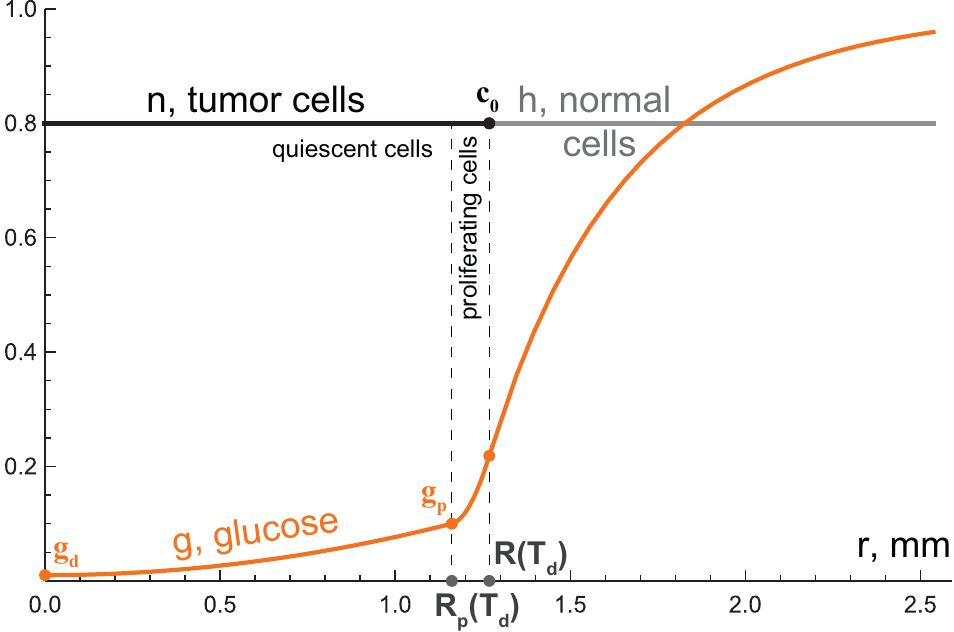
Figure 3. The distributions of the variables of the tumor growth model, governed by the system of Equation (6) at the moment when first tumor cells have just begun to